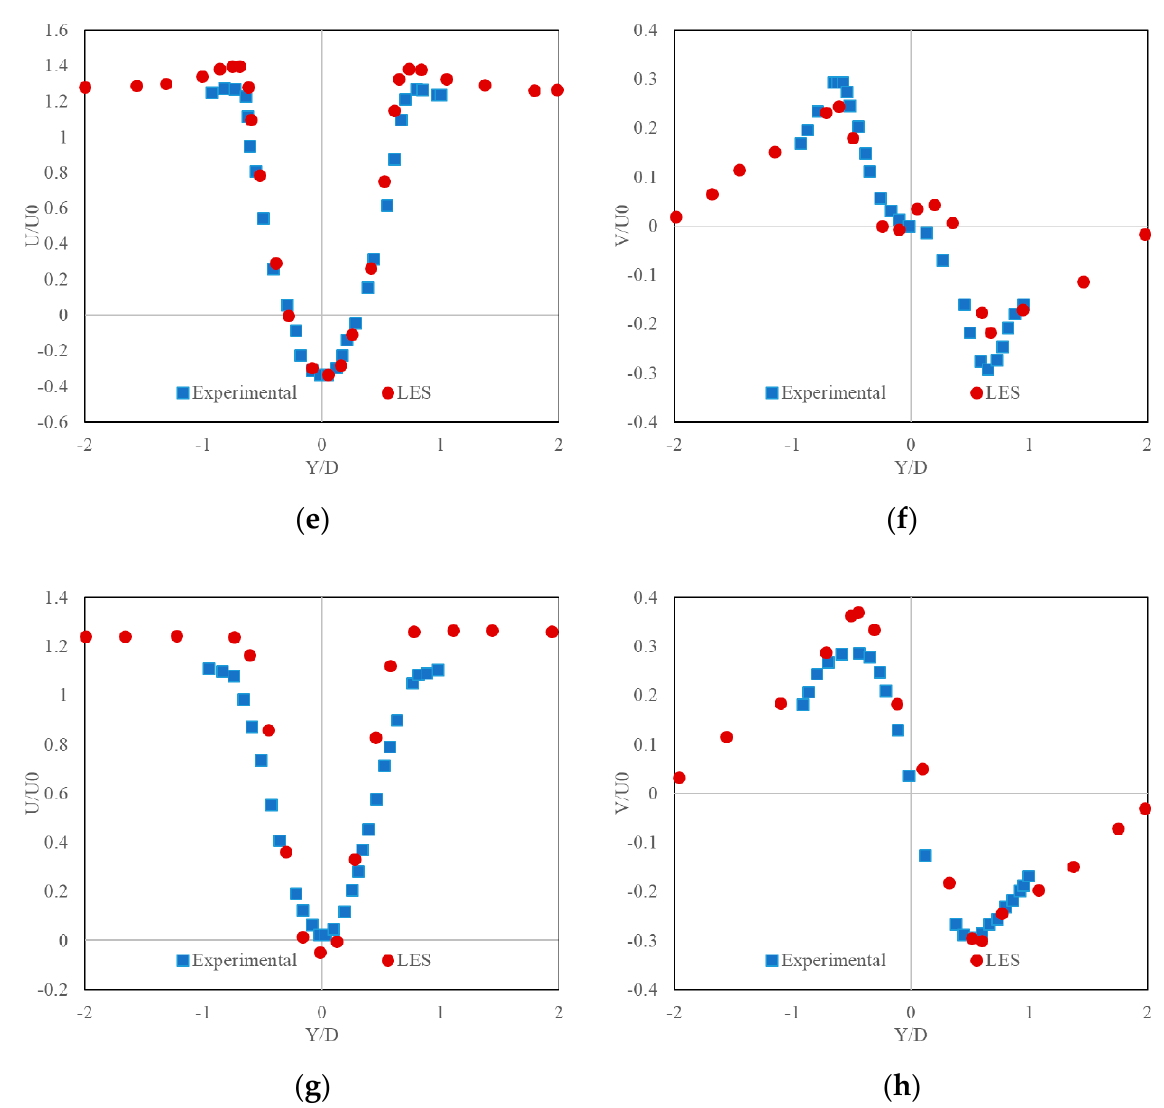
Figure 1. Validation of the LES with experimental data [13]. ( a ) Pressure coefficient along obstacle surface; ( b ) Mean stream-wise velocity distribution along centerline; ( c ) Mean stream-wise velocity profiles at X/D = 1.06; ( d ) Mean transverse velocity profiles at X/D = 1.06; ( e ) Mean stream-wise velocity profiles at X/D = 1.54; ( f ) Mean transverse velocity profiles at X/D = 1.54; ( g ) Mean stream-wise velocity profiles at X/D = 2.02; ( h ) Mean transverse velocity profiles at X/D = 2.02.